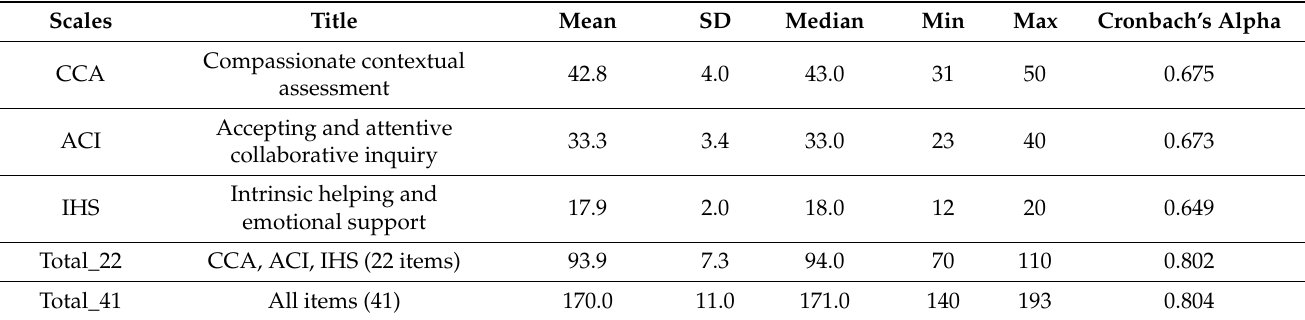
Table 2. Descriptive statistics for the ESWW scale (total scores and its components).